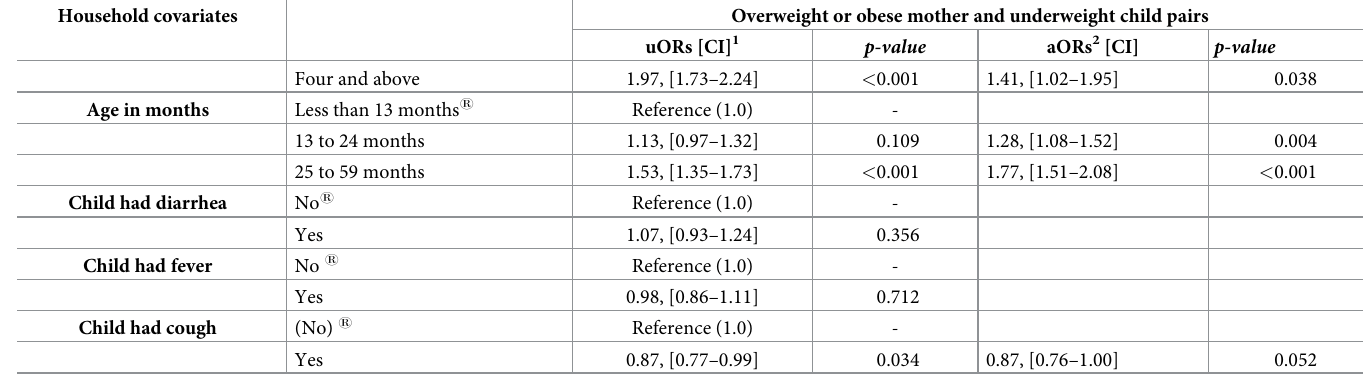
1 .Odds ratios and confidence interval at 5% significance level of bivariate regression models. 2 . Odds ratios in multivariable model after adjusting for the variables which were significant at 5% level in bivariate